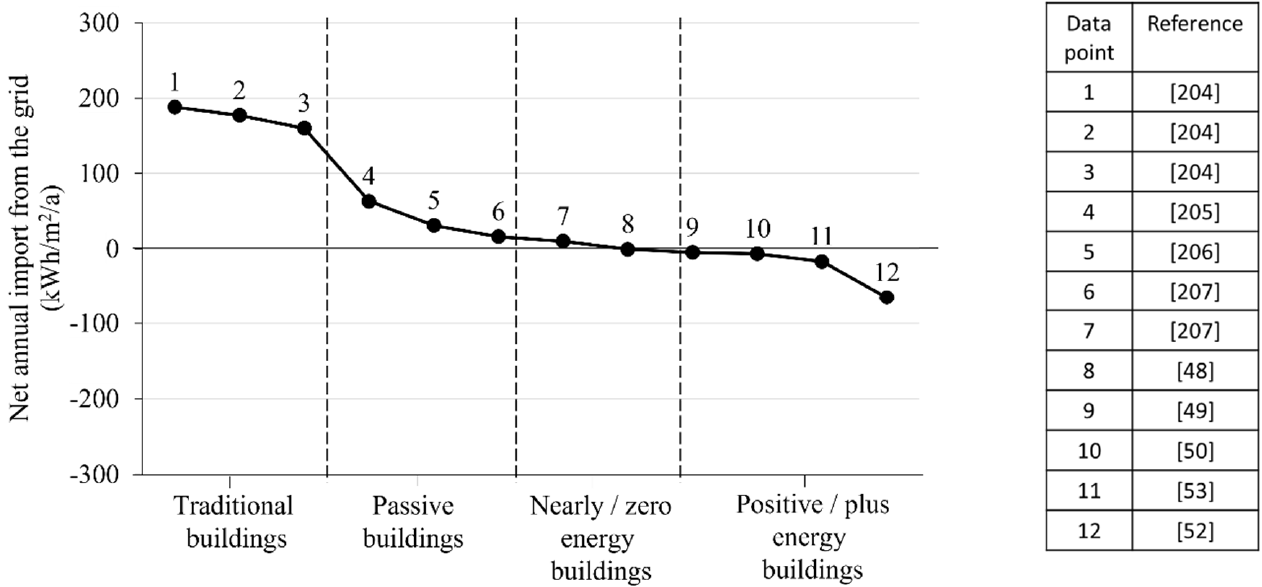
Figure 8. Quantitative comparison of PEBs with the traditional buildings, passive buildings, and zero energy buildings .